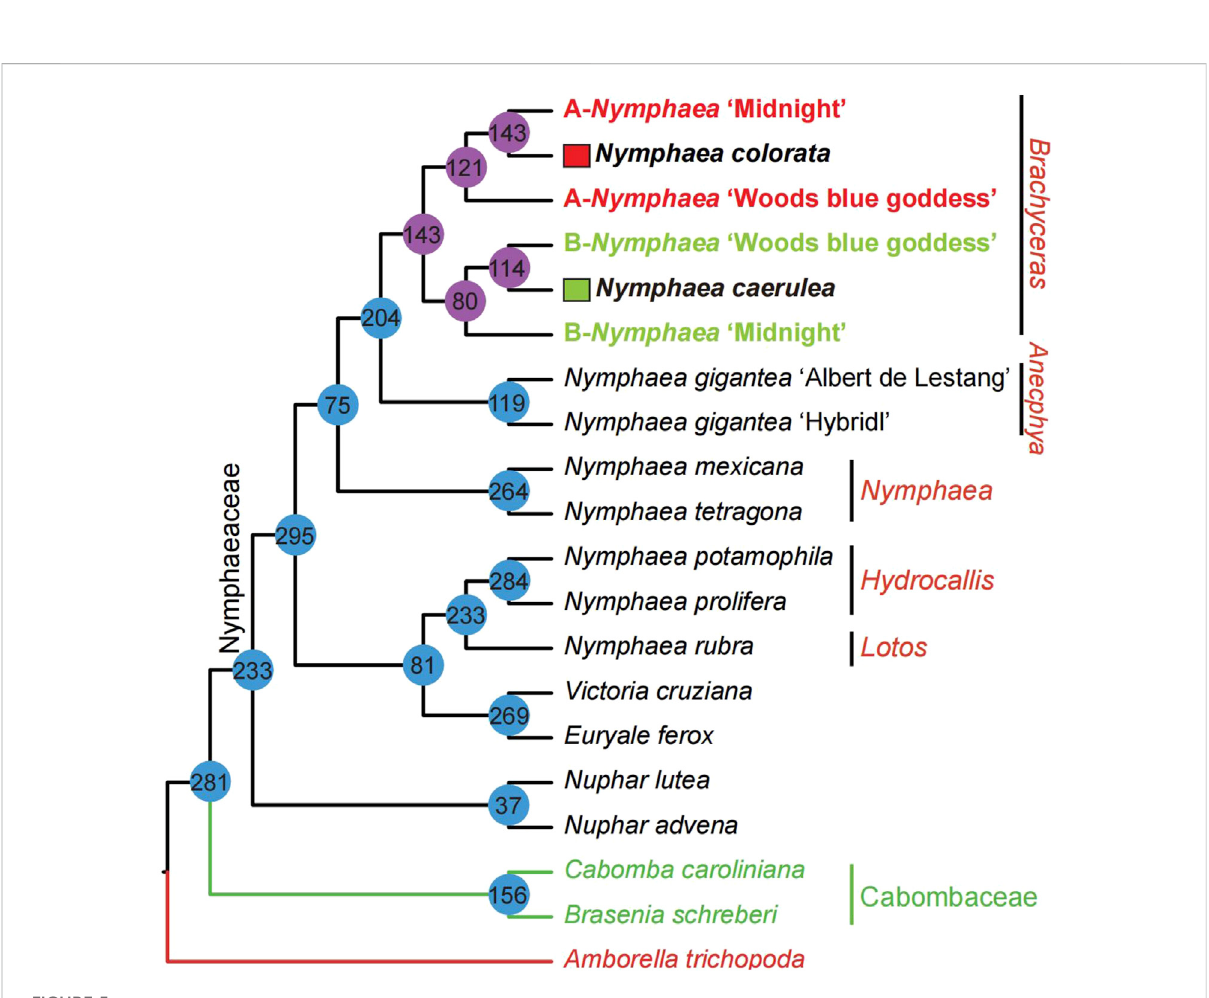
FIGURE 5 The topology statistics of multi-labeled gene family trees mapping to the Nymphaeales phylogeny. A total of 300 multi-labeled gene family trees were used to count the topology and the detailed gene selection and processing pipeline were described in Figure 2. The number inside the circle on the phylogenetic tree nodes shows the number of gene families that support the phylogenetic